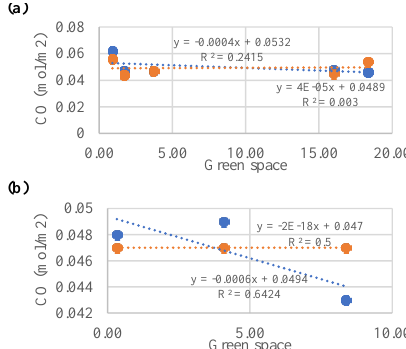
Figure 17. Influence of green space on CO